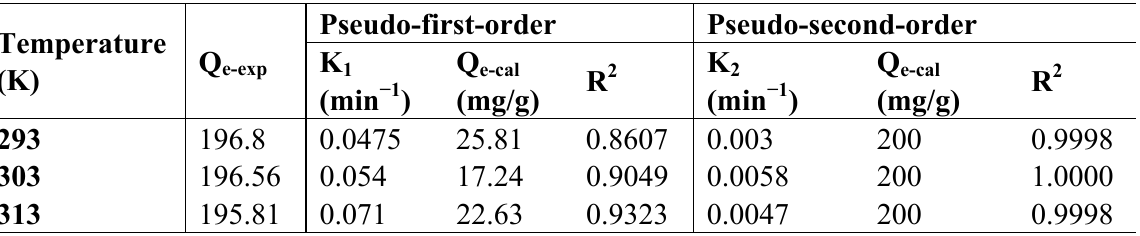
Table 2. Kinetic parameters for three different temperatures.